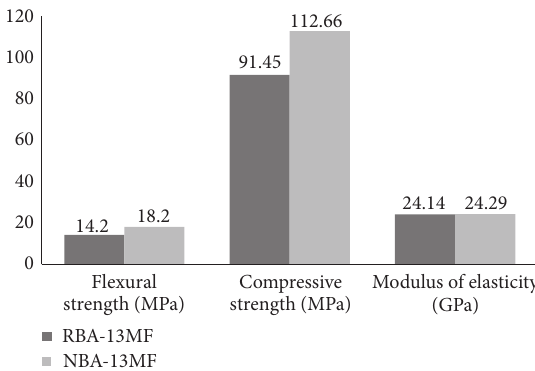
Figure 12: Comparison of the obtained mechanical properties form RBA-13MF and